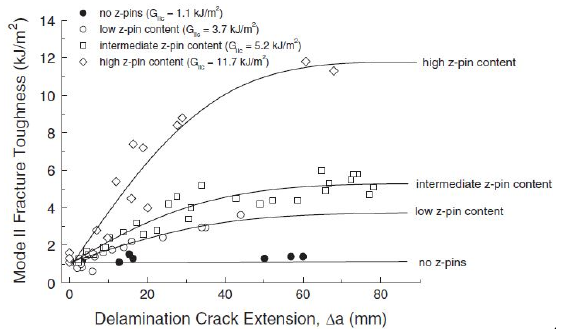
Figure 60. E ff ect of z-Pin content on the mode II apparent fracture toughness of a z-Pinned laminate (CFRP z-Pins, d = 0.28mm, [0 6 [0 / 90] 2 ] s pre-preg) [27].